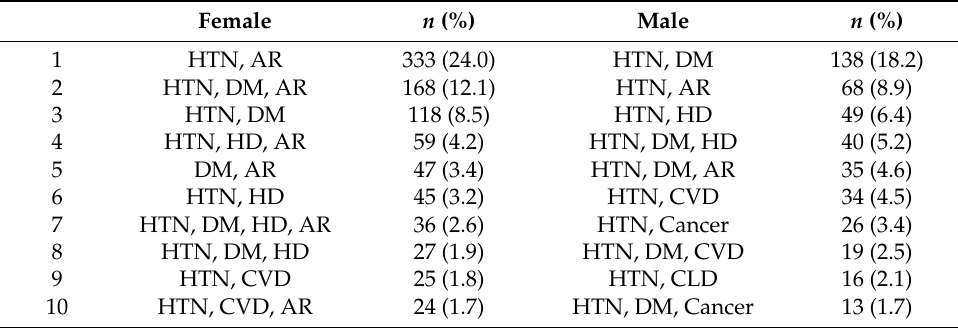
Table 2. The most frequent multimorbidity type by gender.